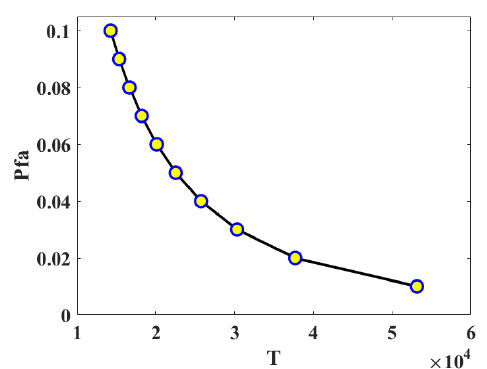
Figure 4. Relationship between P fa and the decision threshold T .